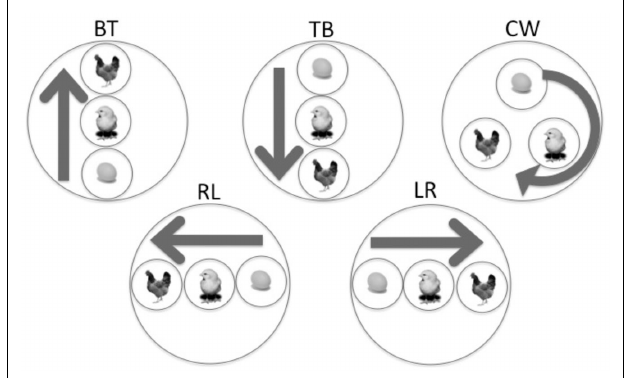
FIGURE 2 |The five observed patterns of arrangement.